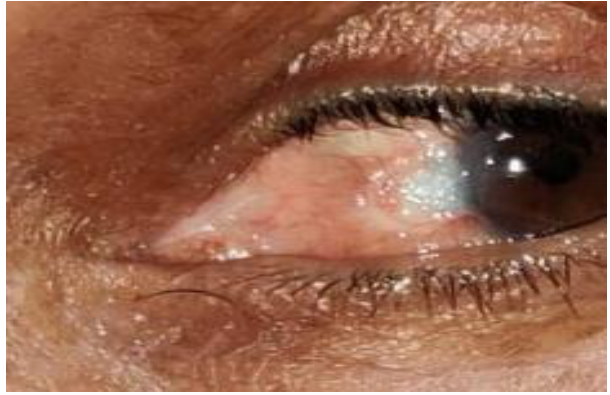
Fig. 6. Conjunctival growth towards limbus started after three days of patching.